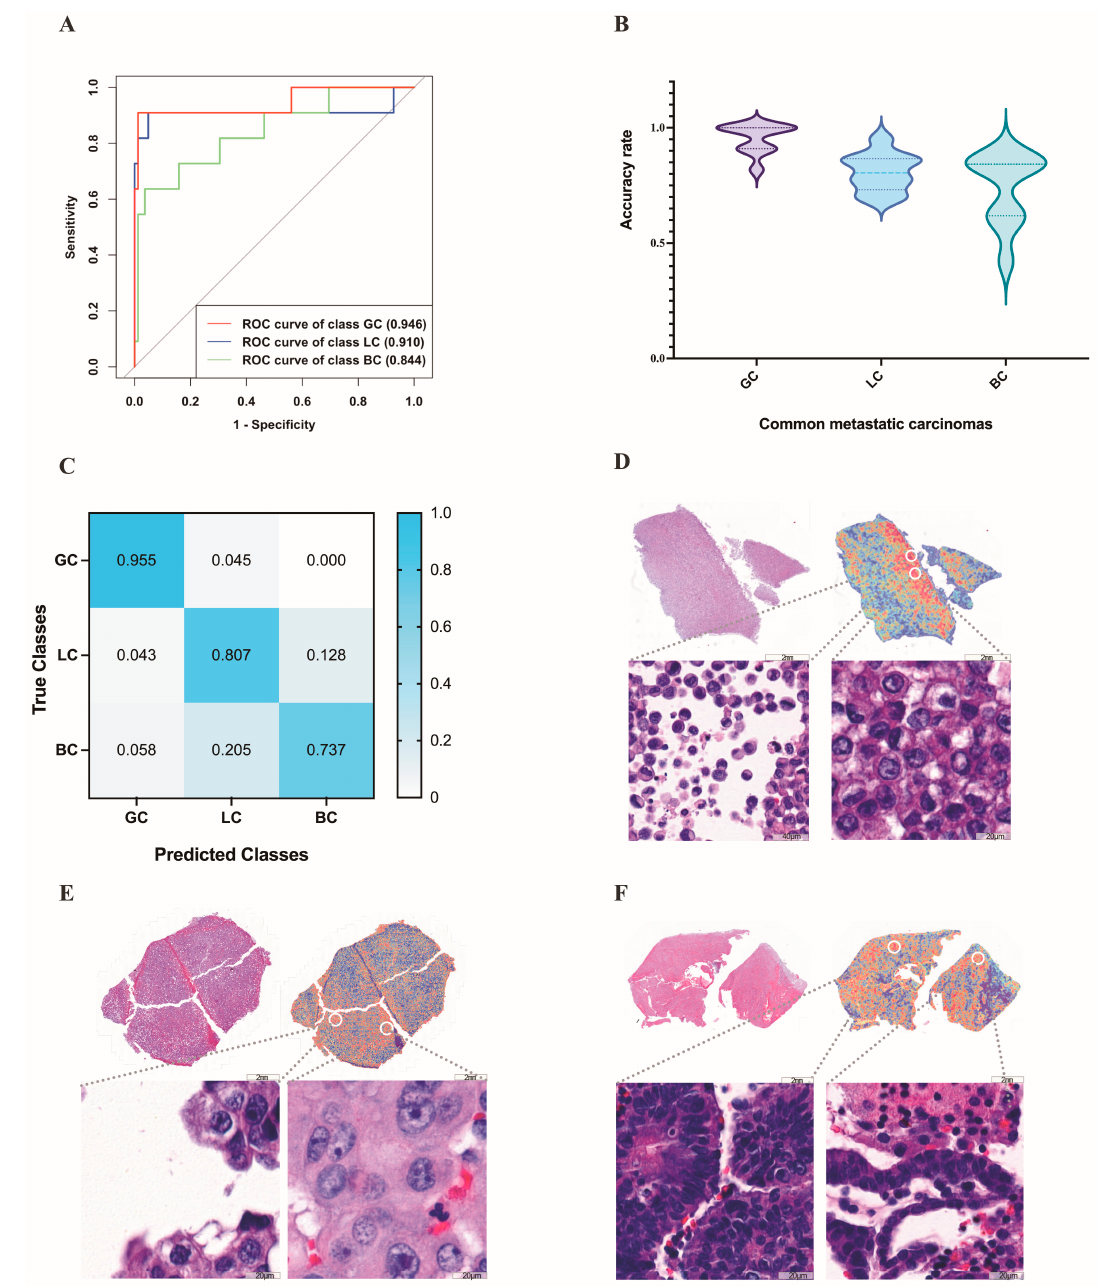
Figure 7. Results of the deep learning models in the identification of the primary site of metastatic carcinoma. ( A ) The ROC curve used for the common metastatic carcinomas on the test set. ( B ) The average accuracy rate of common metastatic carcinomas predicted by deep learning. ( C ) The confusion matrix used for the common metastatic carcinomas on the test set. ( D – F ) High-attention regions in the classification tasks. The gastric adenocarcinoma ( D ) highlights predominantly scattered isolated malignant cells, whereas the trained model for lung adenocarcinoma ( E ) emphasizes clusters with unregular borders and cellular pleomorphism. For breast invasive ductal carcinoma ( F ), the model emphasizes acini/glands or round cell groups. GC: gastric adenocarcinoma; LC: lung adenocarcinoma; BC: breast invasive ductal carcinoma.